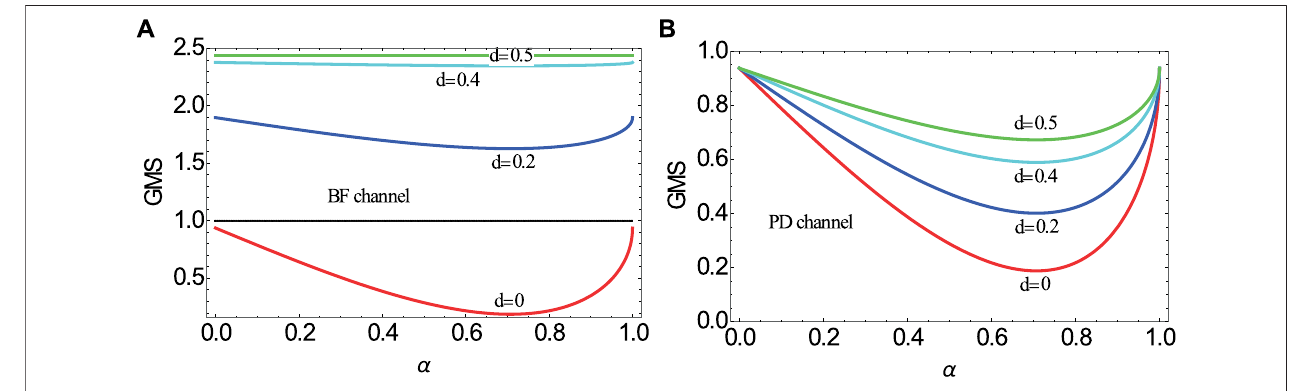
FIGURE 2 | (Color online) GMS-inequality as a function of the state parameter α in terms of different channel-noise factors d for Q (cid:2) 1, when the initial three-qubit state is under the different noisy channels. (A) BF channel. (B) PD channel.